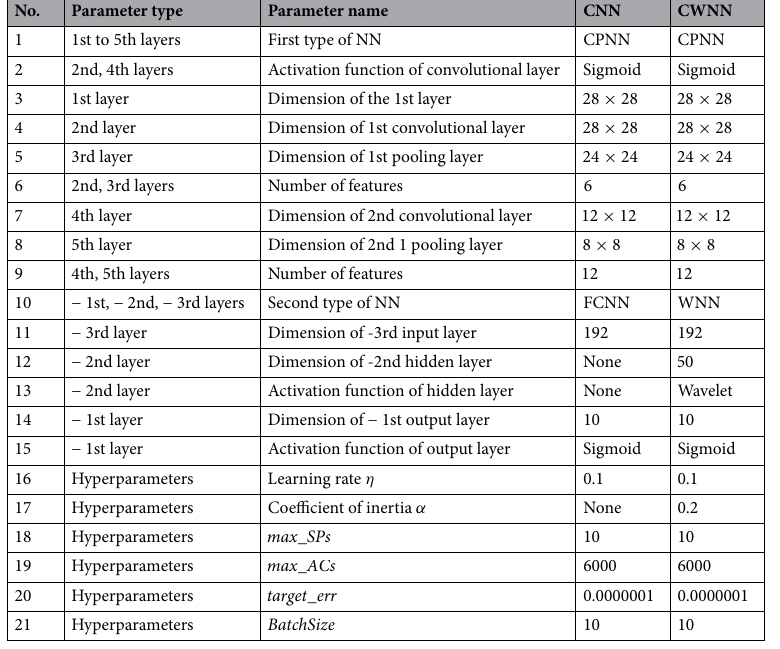
Table 6. Configurations of CNN, CWNN experiments.